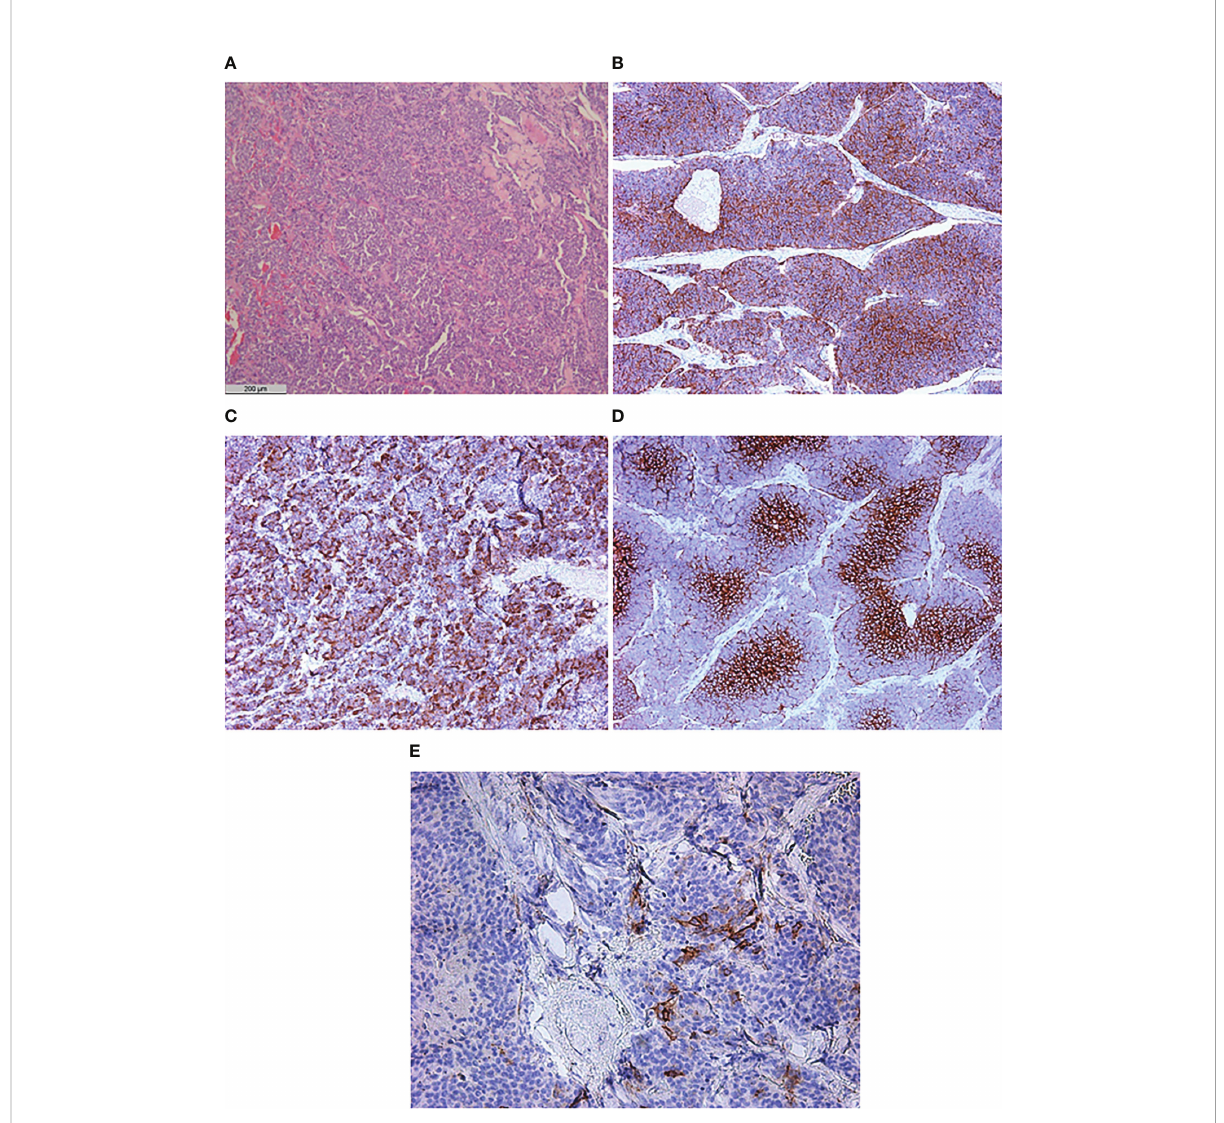
FIGURE 2 Histological and immunohistochemical examination of primary neuroendocrine tumor of the left ovary. (A) Hematoxylin and eosin staining ×50. (B) CD56 ×50. (C) ACTH ×50. (D) GLUT-1 ×100. (E) SSTR 5 subtype